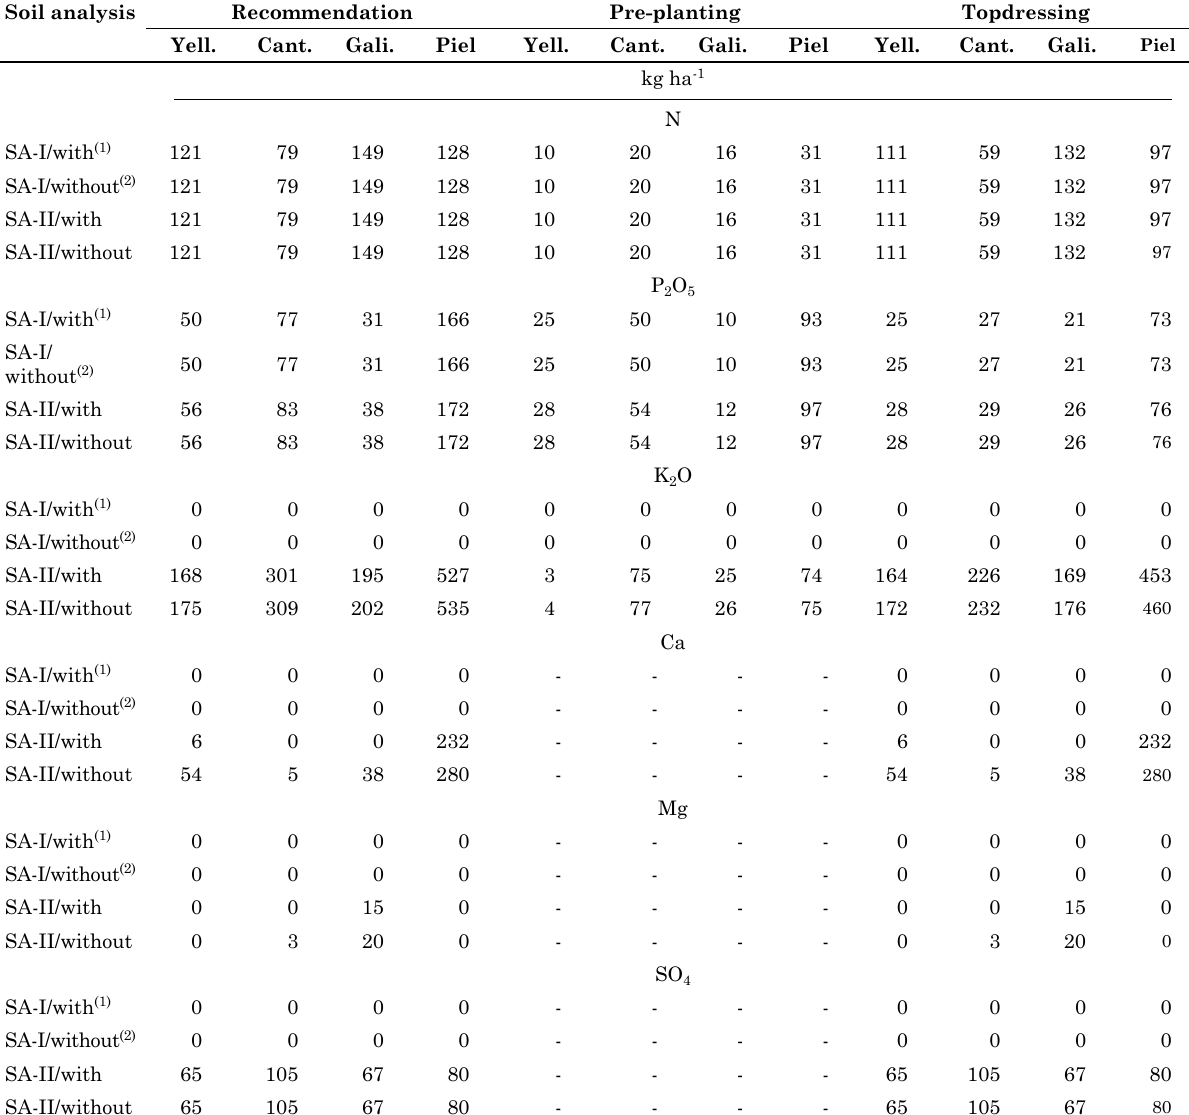
Table 9. Ferticalc-melon recommendations for total nutrient application and distribution in pre-planting and topdressing (fertigation) considering a yield of 45 t ha